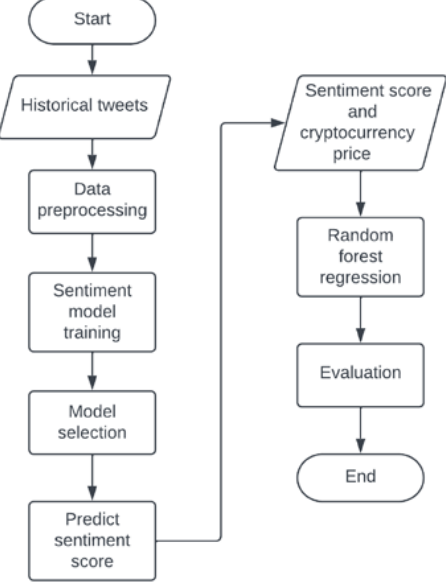
Figure 3. Machine learning model flowchart.